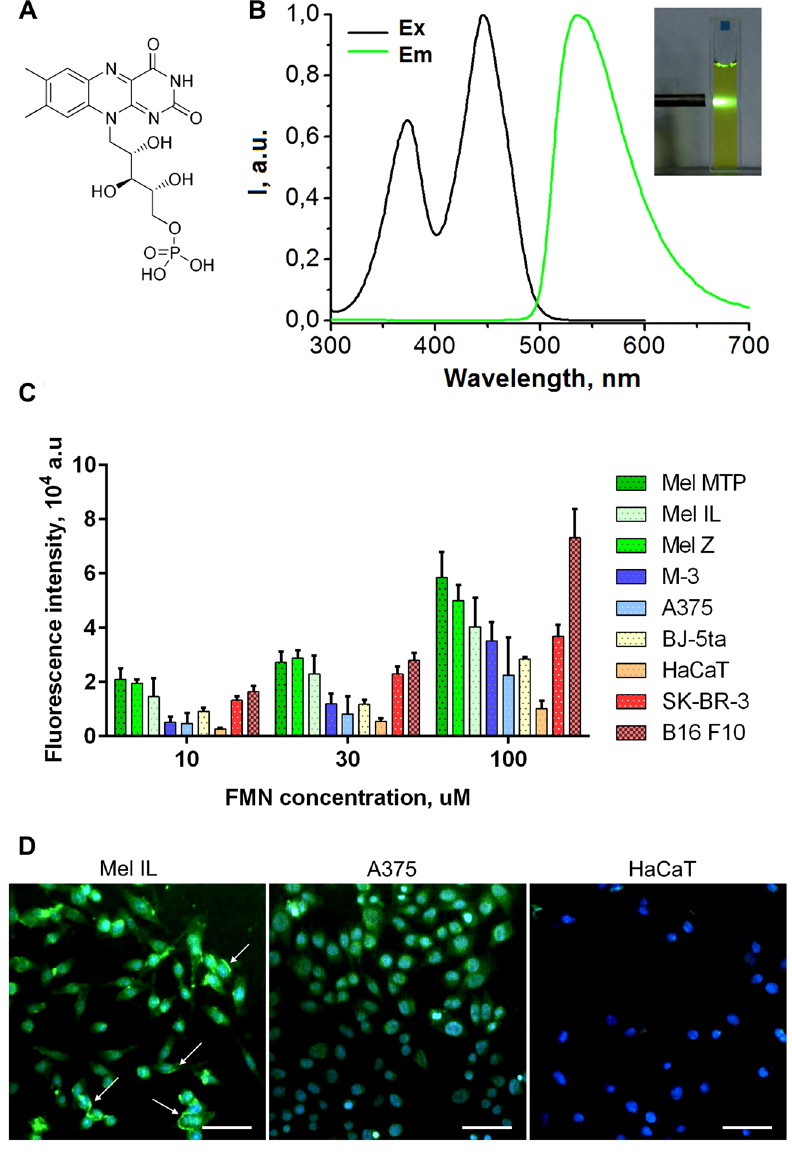
Figure 1. The formula ( A ) and the excitation and emission spectra of FMN in PBS (pH 7.4) ( B ); photoluminescence of FMN under 450 nm excitation are shown in insert. The accumulation of FMN in tumor and normal cells: flow cytometry data ( C ) and confocal microscopy ( D ). Flow cytometry measurements were performed at least in three independent experiments, and the data were expressed as mean ± SD. For confocal imaging, cells were incubated with 100 µ M FMN solution for 30 min. Cell nucleuses are in blue (Hoechst 33258), FMN is in green. White arrows show the FMN accumulation on the cell membrane. Scale bar is 50 µ